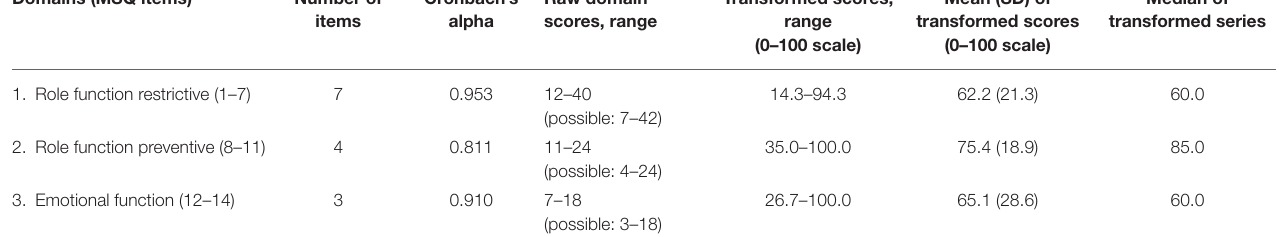
TABLE 2 | Results obtained by the migraine-specific quality-of-life (MSQ) questionnaire (assessed during the last 4 weeks of erenumab treatment). Domains (MSQ items)